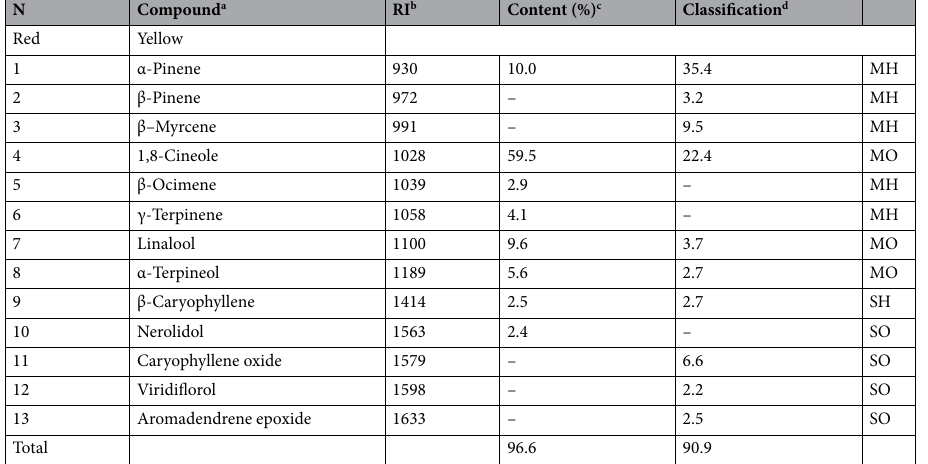
Table 1. Chemical constituents of leaf oil from red and yellow morphotypes of Psidium cattleyanum . a Major compounds listed in the elution order using Rtx ® -5MS column. b RI: Retention index determined by the normalization of retention times with respect to an n-alkane mixture (C7–C40) 87–89 . c Compounds with a relative area of > 2% were identified. d Terpenic classification: oxygenated monoterpene (MO), hydrogenated sesquiterpene (SH), oxygenated sesquiterpene (SO).